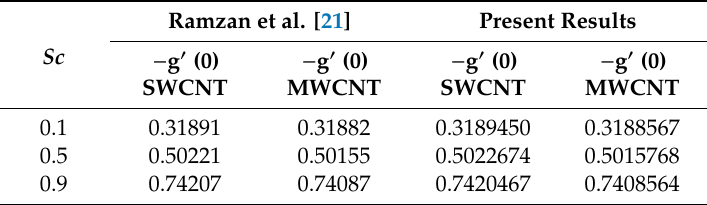
Table 1. Numerical variation of mass transfer rate Sh x and their comparison with Ref. [21] via various value of Sc at G r = n = 0.1, N r =